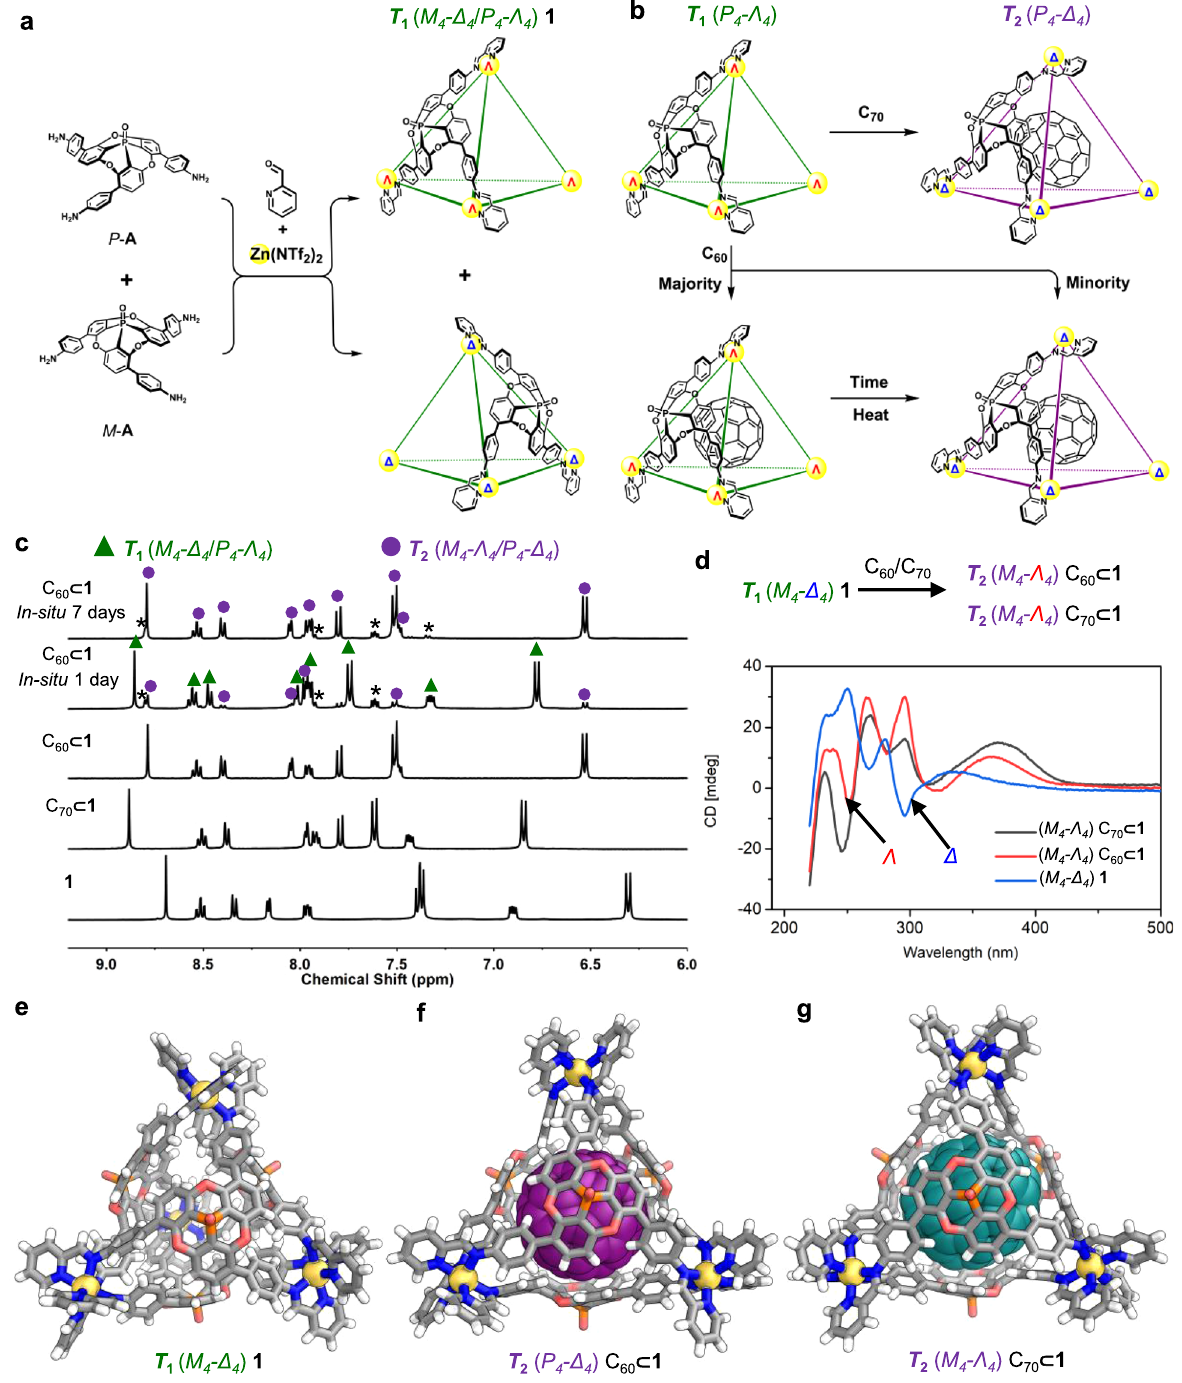
Fig. 1 Synthesis of cage 1 and induced fi t of C 60 and C 70 guests. a The self-sorting preparation of cage 1 from chiral subcomponent A as a single pair of enantiomers. b The conversion of cage diastereomer T 1 into T 2 upon fullerene binding. c 1 H NMR spectra of 1 and its C 70 and C 60 adducts, showing the evolution of the C 60 adduct from the T 1 con fi guration (green triangles) into the T 2 (violet circles) over 7 days; residual 2-formylpyridine signals are labeled with asterisks. d CD spectra of 0.03 mM acetonitrile solutions of the host and host – guest complexes prepared with enantiopure subcomponent M - A (spectra for assemblies with subcomponent P - A are shown in Supplementary Fig. 84). g X-ray crystal structures showing 1 in its preferred T 1 con fi